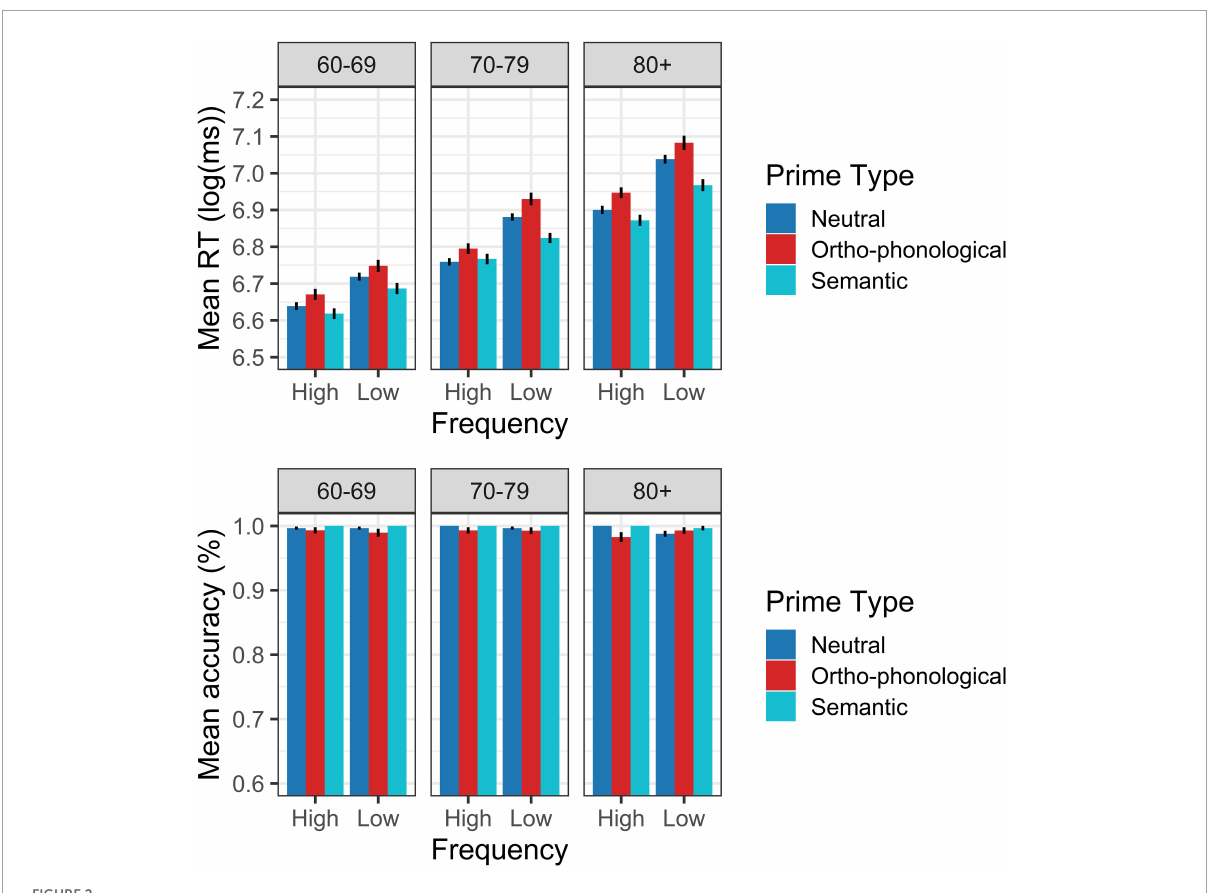
FIGURE2 Word response pattern on RT (log) and accuracy in Experiment